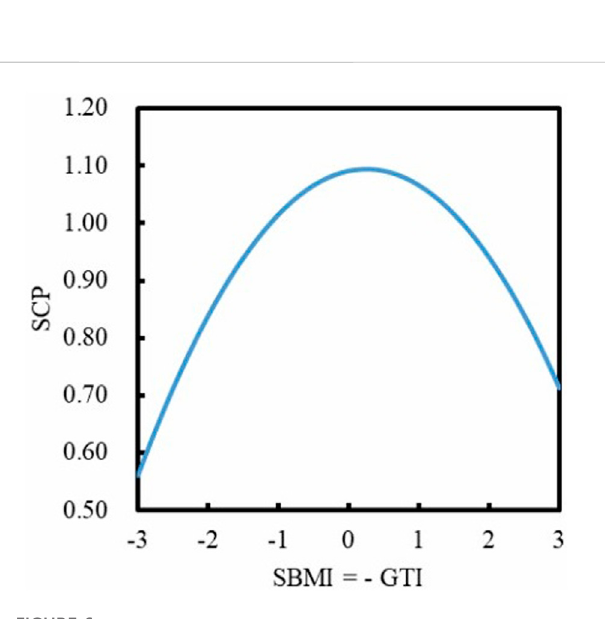
FIGURE 6 Side view of response surface along inconsistency